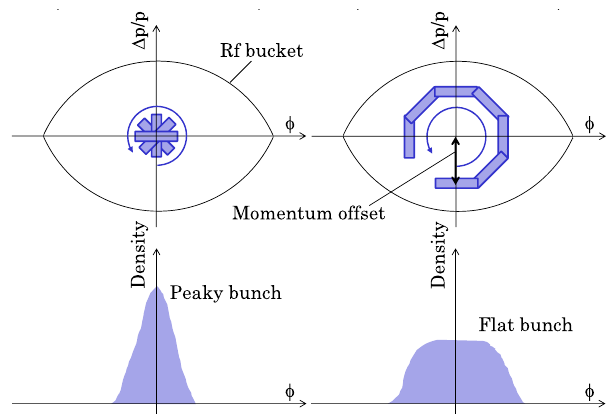
FIG. 6. Schematic diagram of the longitudinal motion for the multiturn injection process without (left) and with (right) a momentum offset, where the boxes represent the injection bunch train from the